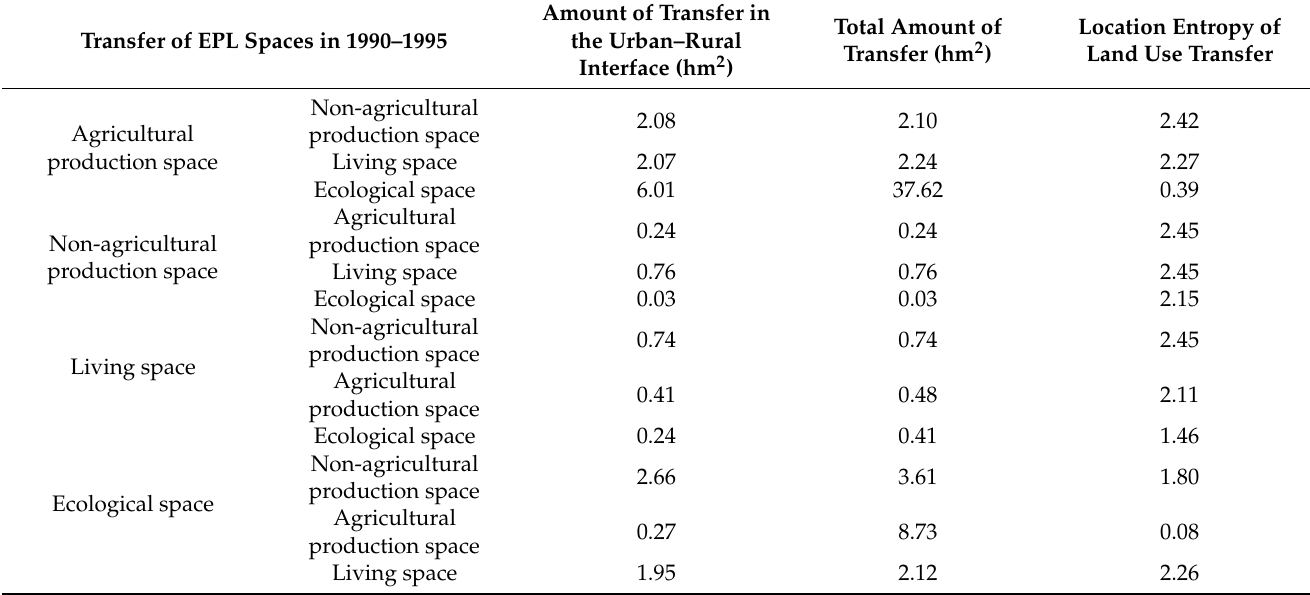
Transfer of EPL Spaces in 1990–1995